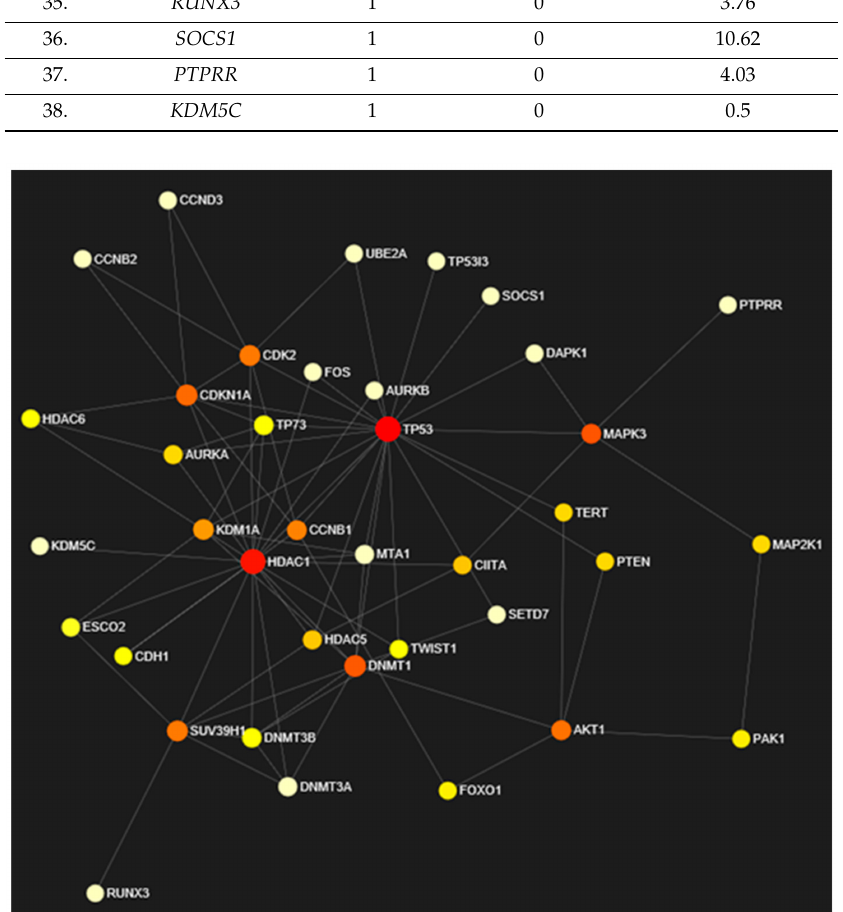
Figure 7. Network based on expression and topological characteristics of input target